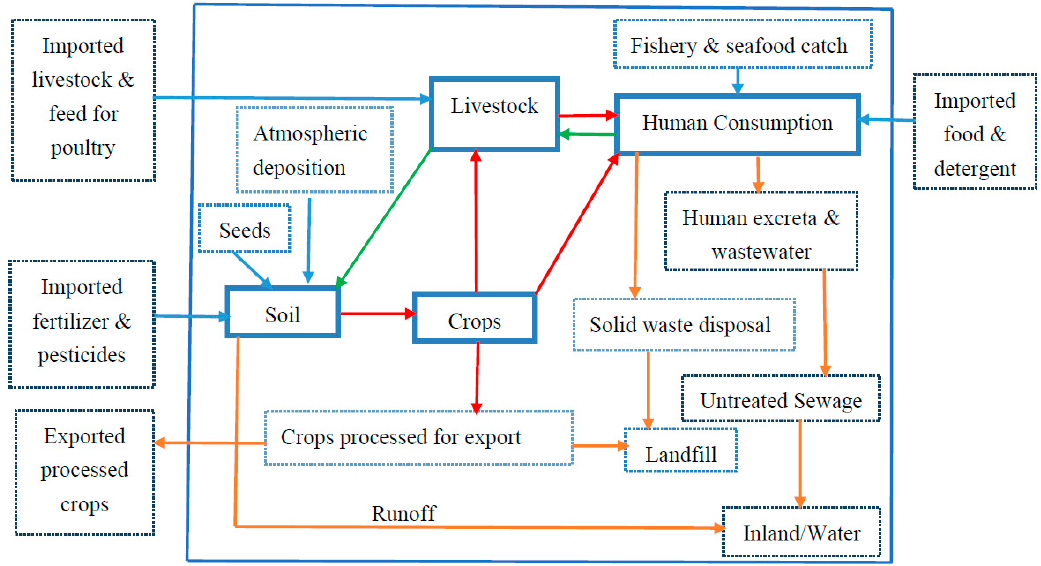
Figure 2. Framework for the P flow model through the food production and consumption system of Comoros. Boxes show subsystem processes. Arrows represent input and output flows. Blue arrows indicate P input flows; green arrows, recycling P flows; red arrows, P internal flows between subsystems; and orange arrows, P output flows.